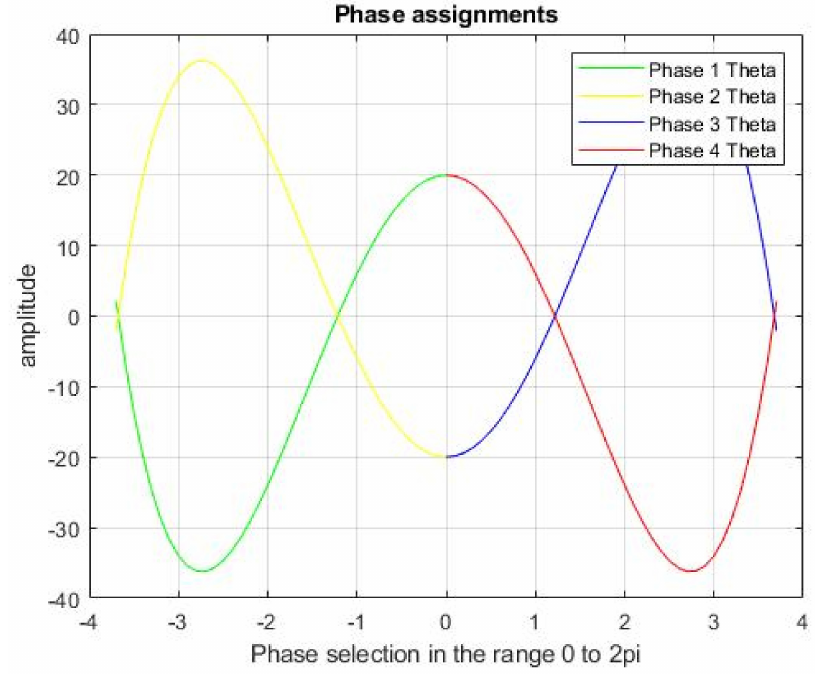
Figure 2. QPSK phase assignment domains.